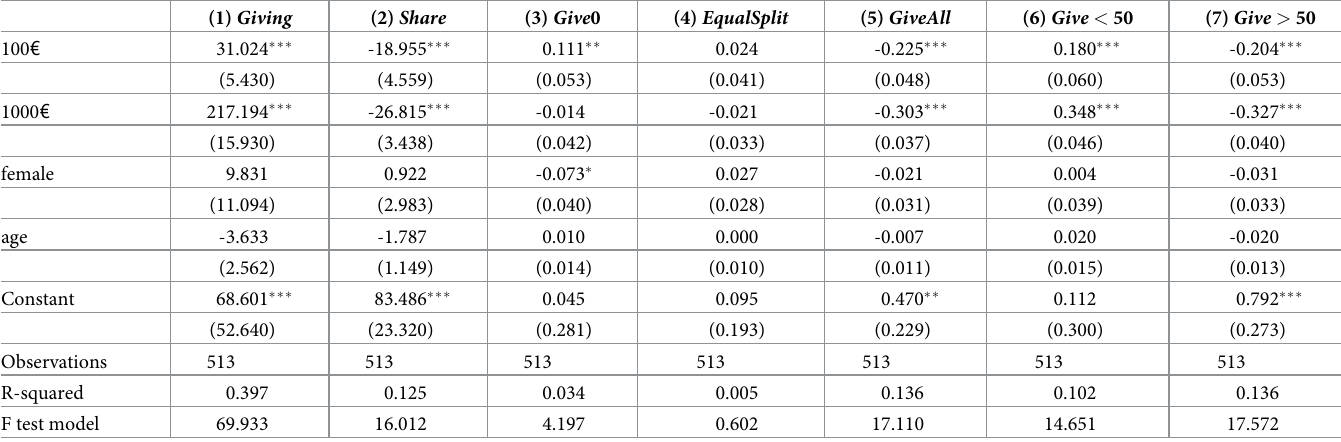
Table 1. OLS estimation of the treatments